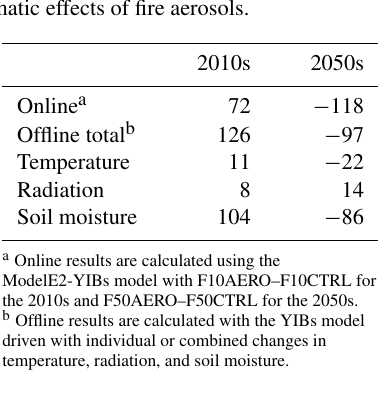
Table 5. Changes in NPP (TgCyr − 1 ) caused by composite and in- dividual climatic effects of fire